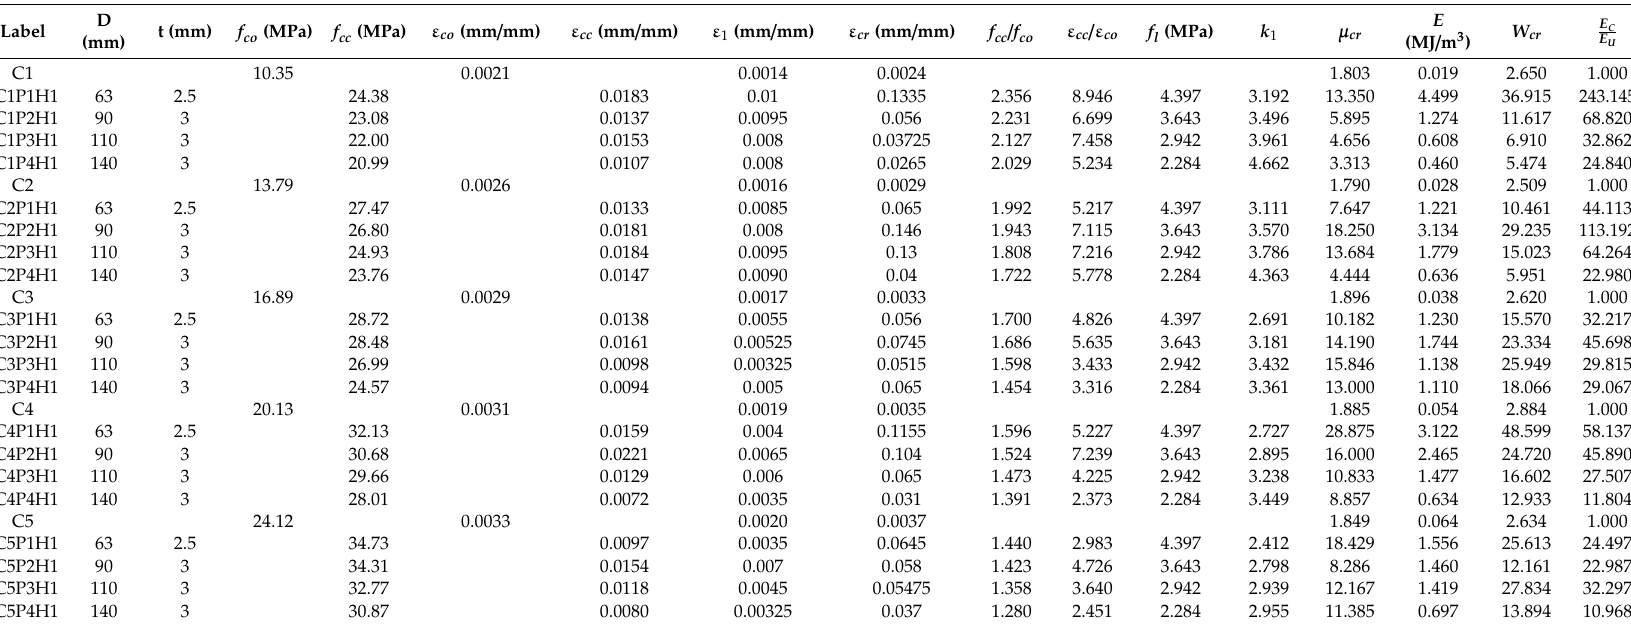
Table 7. Average Maximum Strength, Strain, Confinement Contribution, Energy absorption, Work Index, and Ductility